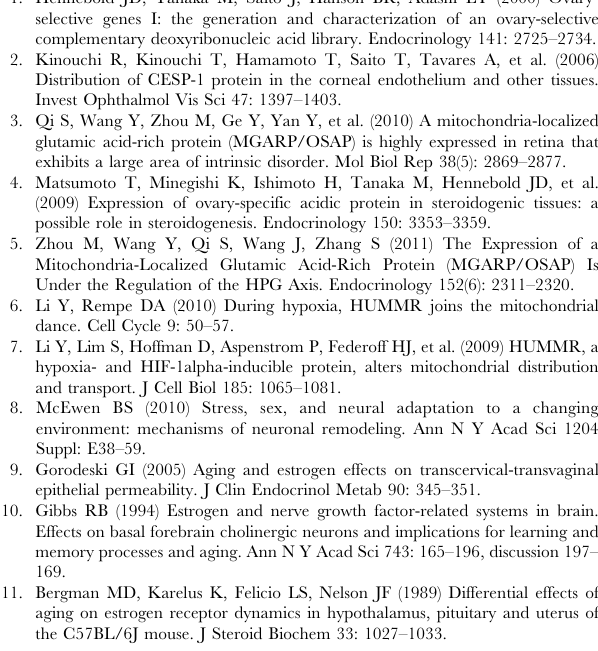
Figure S2 Analysis of different truncated MGARP promoter activity by red fluorescent protein. Figure S3 Endogenous expression of MGARP in HEK- 293T cells and Y1 cells. Table S1 Primers for constructing different deletion reporter